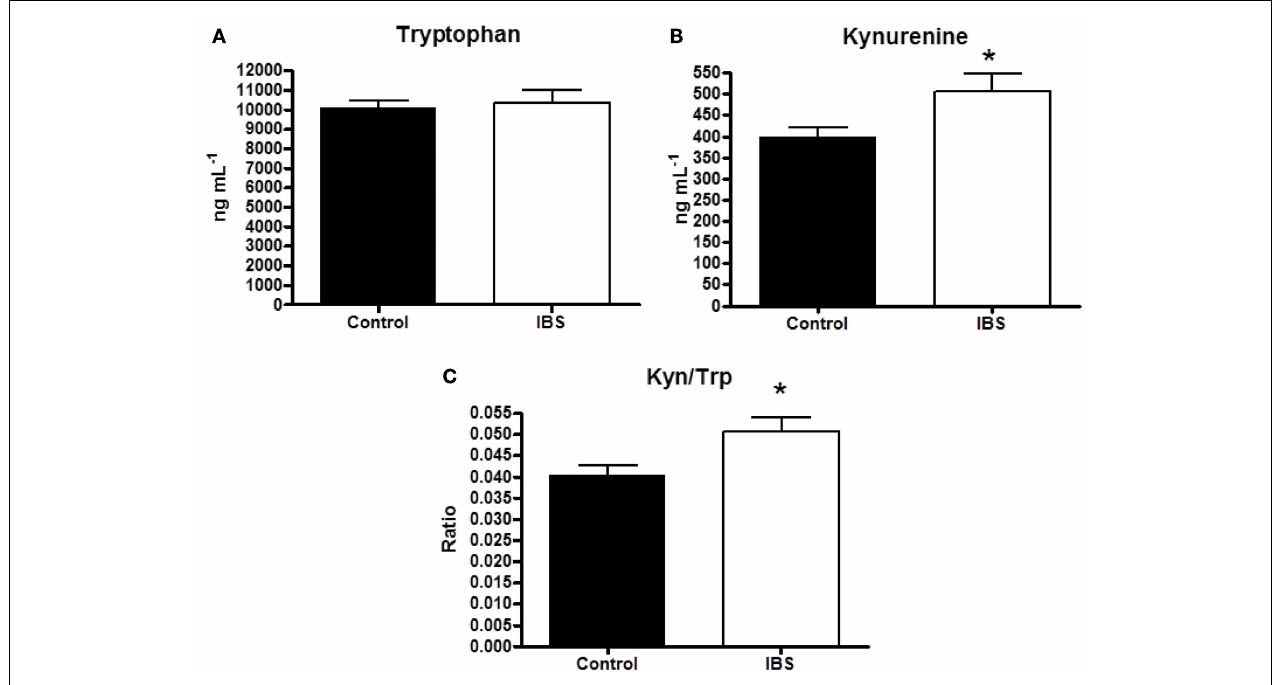
(Kyn:Tryp) ratio in healthy controls and IBS patients. Data are expressed as means ± SEM. Statistical differences between healthy controls and IBS patients were determined using Student’s t -test. * p < 0.05.